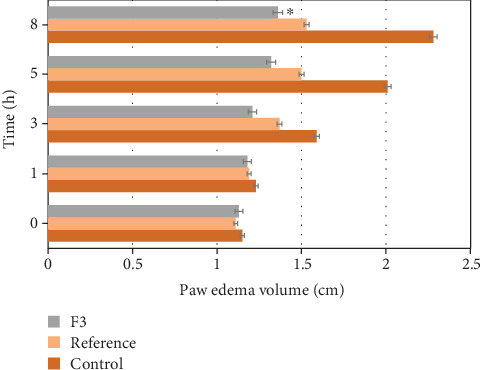
Effect of CXB on carrageenan-induced rat paw edema at different time intervals. Results are given as mean ± SEM (n = 6), ∗Significant effect at p < 0.05.